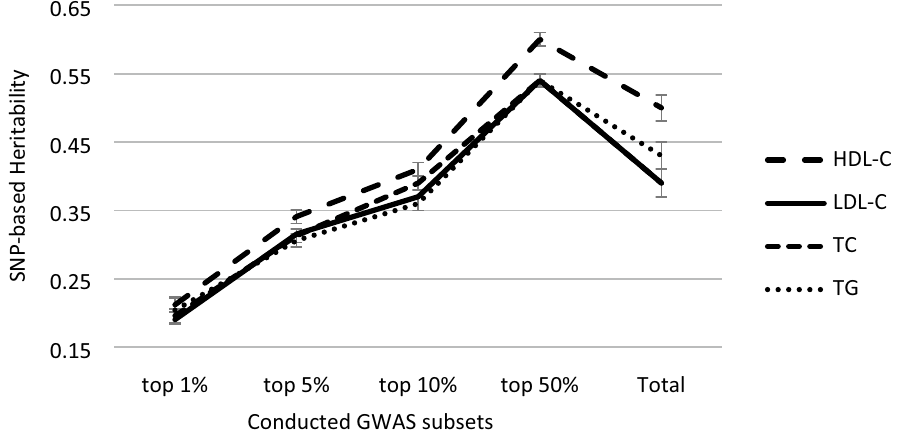
Figure 2. Heritability of lipid profile traits using the shared SNPs in the different repeated fold for different subset selection approaches. Heritability achieved by the shared top 50% approach has higher heritability than other subset selections (top 1%, 5%, and 10%) and than the total SNPs